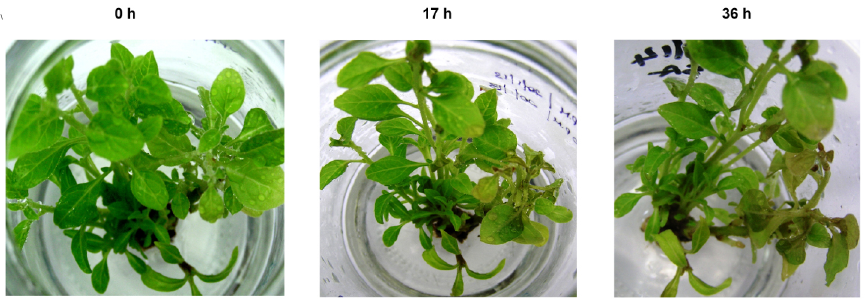
Figure 1. Effect of salicylic acid on in vitro grown plantlets of W. somnifera . 0 h= Plantlets immediately after application of SA; 17 h= Plantlets after 17 hours post SA treatment; 36 h= Plantlets after 36 hours post SA treatment.